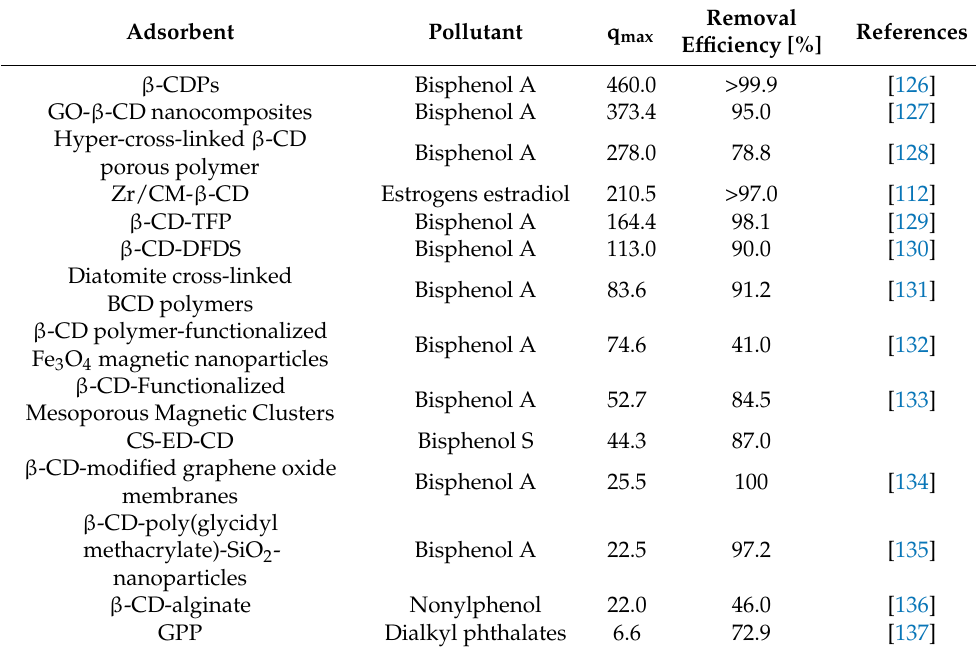
Table 3. Maximum adsorption capacities and removal efficiencies of various CD-based adsorbents for selected endocrine disrupting